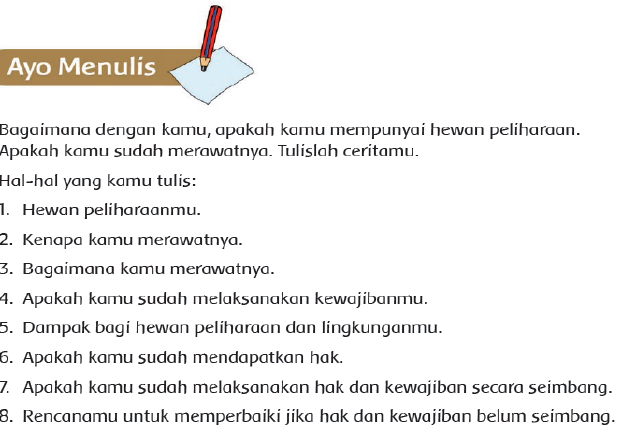
Figure 17 : Writing a story about taking care of